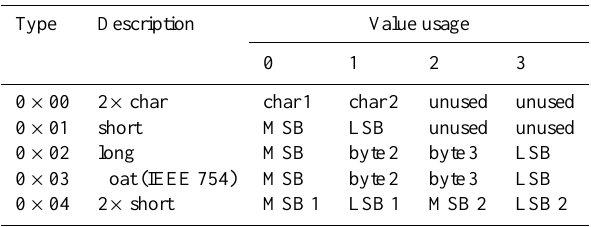
Table 2. Usage of the control data packet optional values according to the specified type. If relevant, the most significant byte (MSB) and the least significant byte (LSB) are indicated. The little-endian convention is